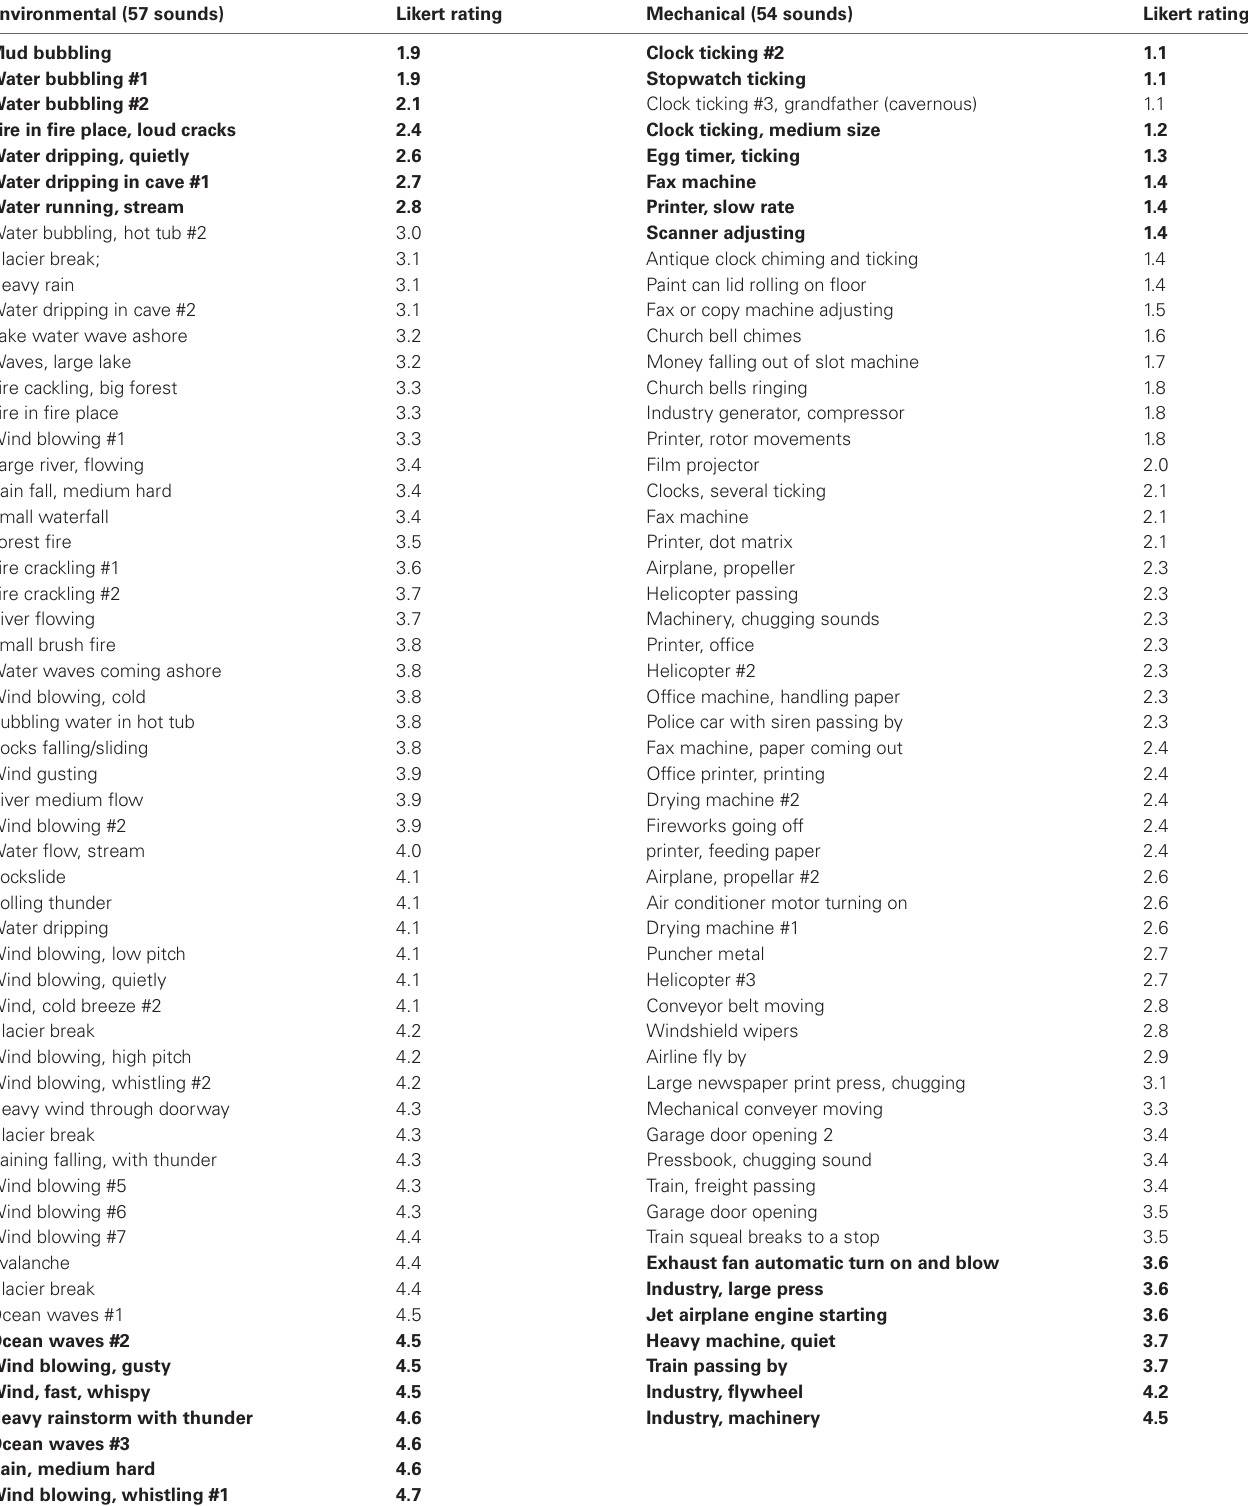
Bold text refers to extreme rated sounds used in Figure 1B